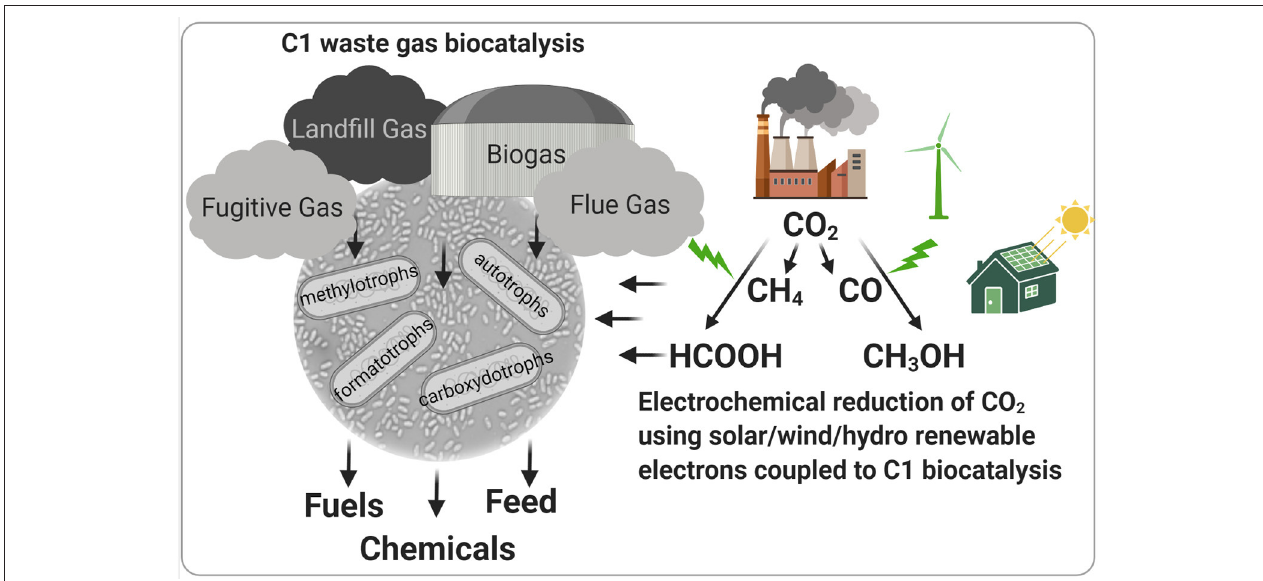
FIGURE 1 | Biotechnologies using C1-utilizing microbes for the conversion of greenhouse and waste gases to valuable products. Specialized microorganisms can valorize one-carbon (C1) sources present in waste gases to fuels, petroleum-derived chemical replacements, and animal and human feed. Electrochemical reduction of industrial flue gas and atmospheric CO 2 using renewable energy-derived electrons represents a novel, sustainable technology to produce C1 carbon sources for natural or engineered C1 biocatalysts. Figure was created with